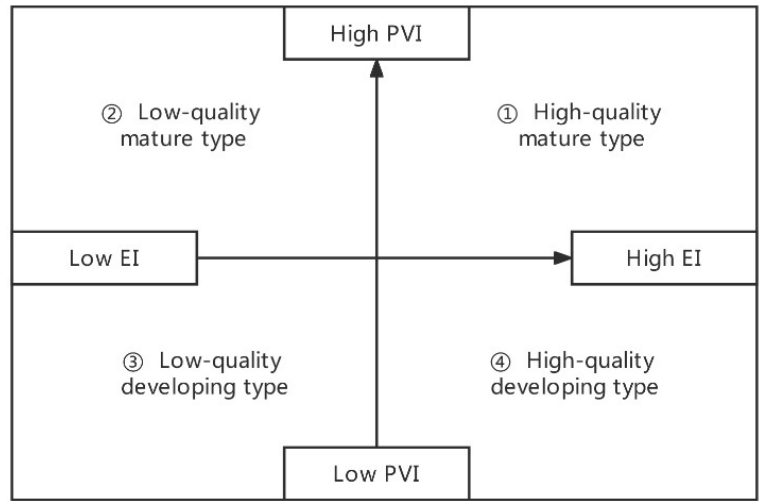
Figure 7. The four-quadrant conceptual model of landscape activity.